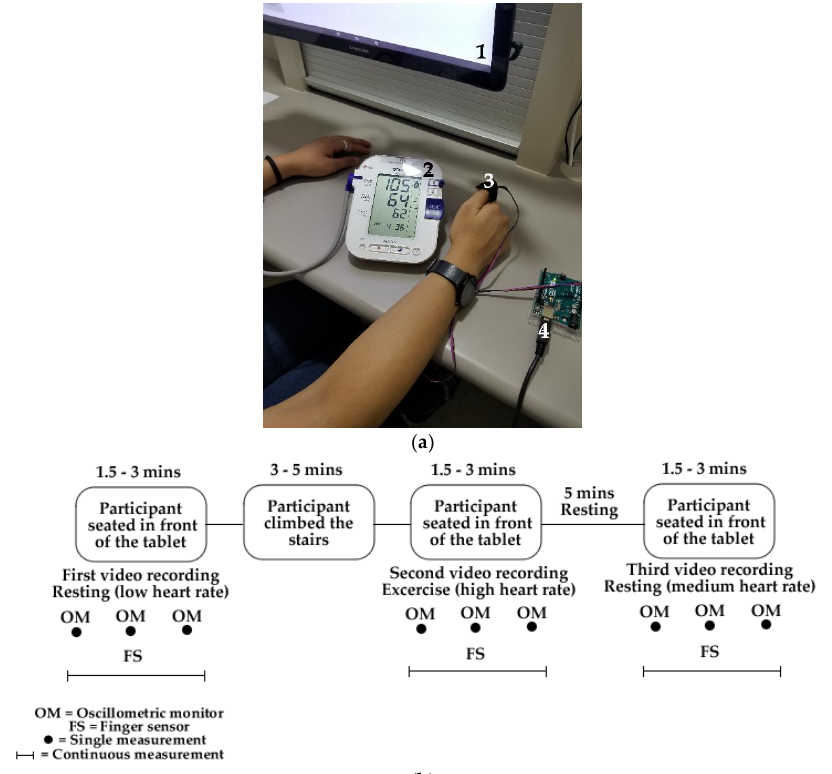
Figure 1. Data gathering set-up showing: ( a ) data acquisition system displaying: (1) the tablet with the Bio-sensory application for video acquisition, (2) oscillometric HR and blood pressure monitor and (3) finger sensor controlled by (4) an Arduino ® board, and ( b ) diagram of the protocol for the data and video acquisition.